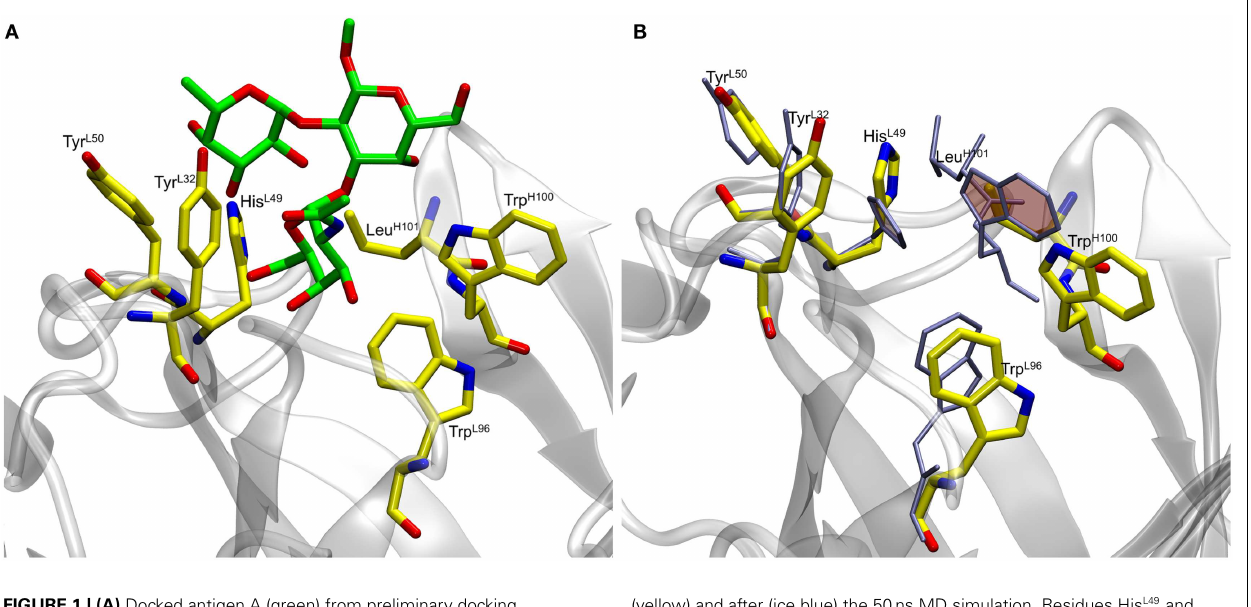
FIGURE 1 | (A) Docked antigen A (green) from preliminary docking experiments with residues lining the binding pocket (shown in yellow).The antibody is shown in gray. (B) Residues lining the binding pocket before